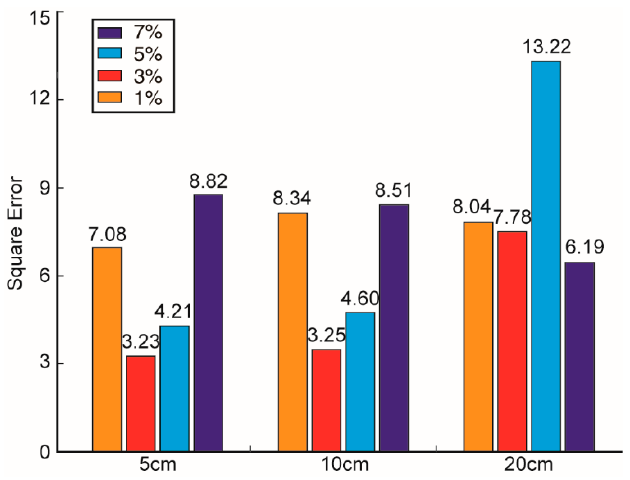
Figure 14. Comparison of square errors between stacked envelopes of the Yutu-2 LPR data and the synthetic data. These square errors are listed in Table 2.